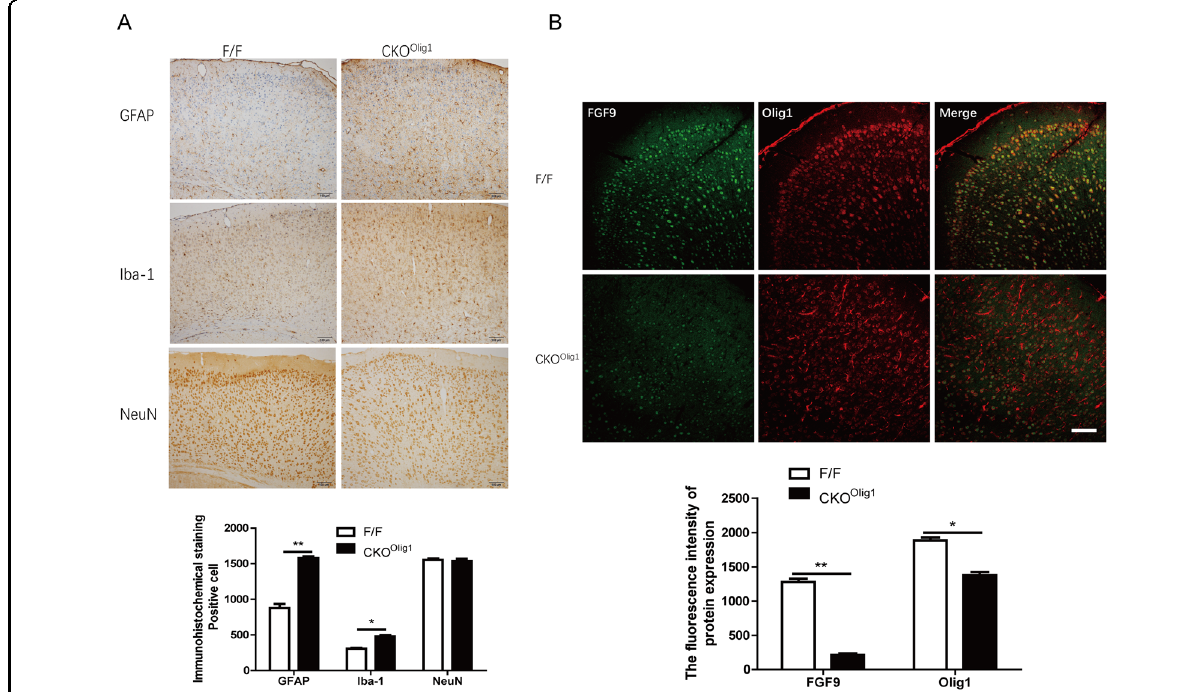
Fig. 2 Abnormal pathological changes are found in the cortex of CKO Olig1 mice. A Immunohistochemical staining for astrocytes, microglia and neurons in the cortex of CKO Olig1 mice and F/F mice. The brain area in the fi gure is the motor cortex. B Immunostaining for FGF9 and Olig1 in the cortex of CKO Olig1 mice. The density of FGF9 (1281 ± 47.4 vs 211 ± 25.7, P = 0.0018) or Olig1 (1885 ± 43.7 vs 1380 ± 43.9, P = 0.0287) in the cortex of F/F and CKO Olig1 mice. Scale bars, 100 μ